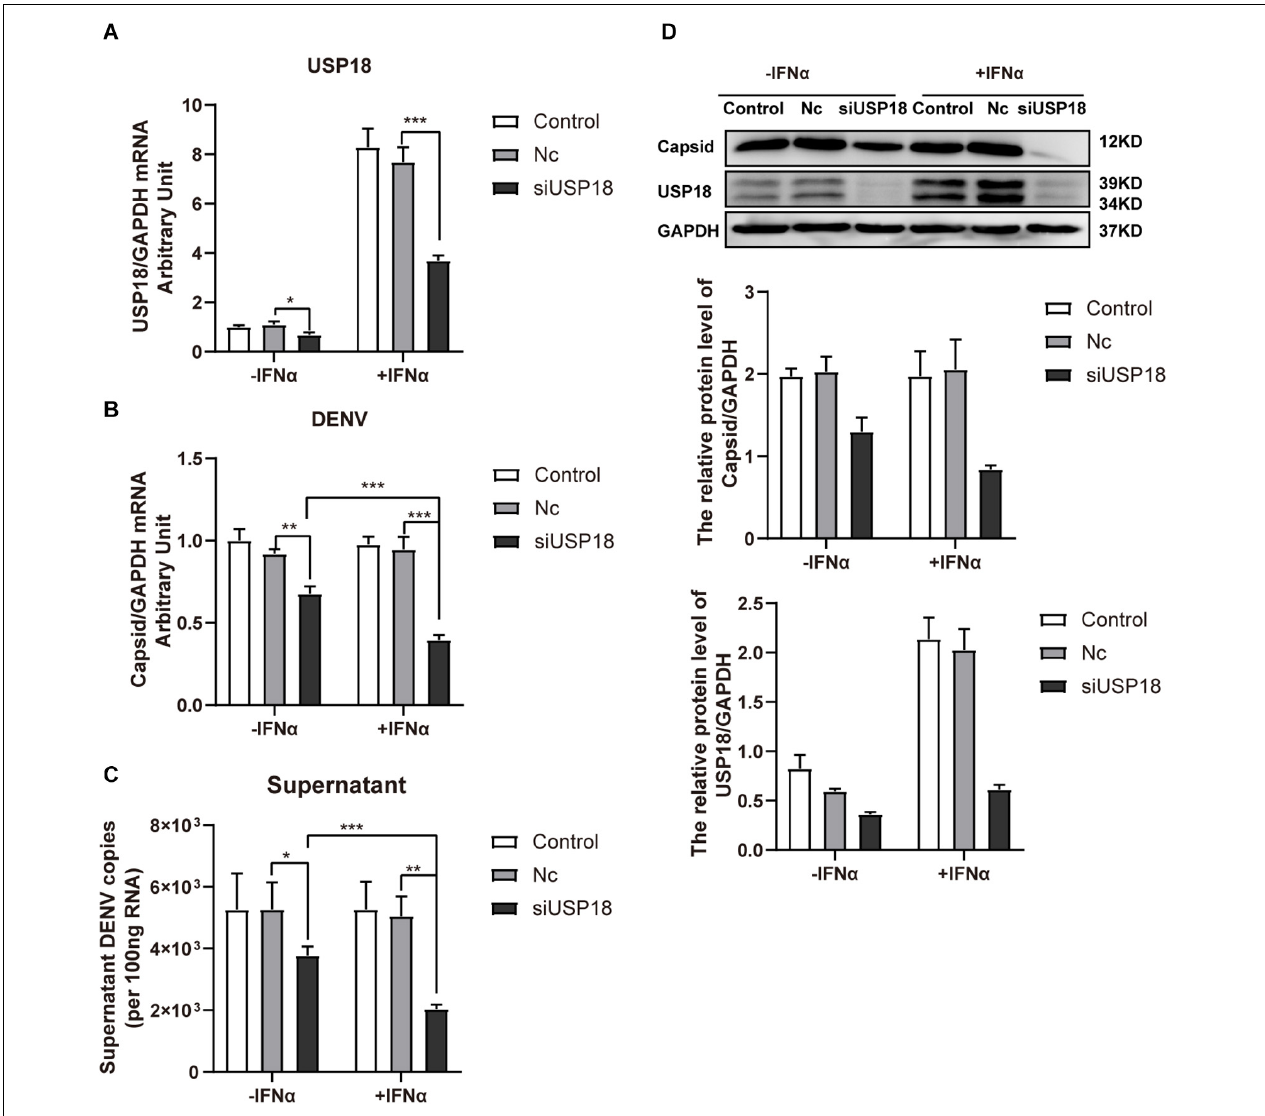
FIGURE 4 | Silencing of USP18 rescues the anti-DENV-2 activity of IFN- α post-DENV infection. Hela cells were transfected with siUSP18 or Nc for 8 h before infected with DENV-2 (MOI = 1) for 24 h, and the cells were treated with 100 IU/mL IFN- α for another 24 h. Cells and culture medium were collected. USP18 knockdown efficiency (A) and levels of DENV-2 RNA (B,C) were determined by real-time PCR, and results were normalized to GAPDH, yielding arbitrary units (fold change). Protein expression of USP18 and DENV-2 capsid was assessed by Western blot with GAPDH as a loading control (D) . –IFN α is without IFN- α treatment, and +IFN α is with IFN- α treatment. Data are presented as mean ± SD, Error bars indicate SD; * P < 0.05, ** P < 0.01, *** P < 0.001.